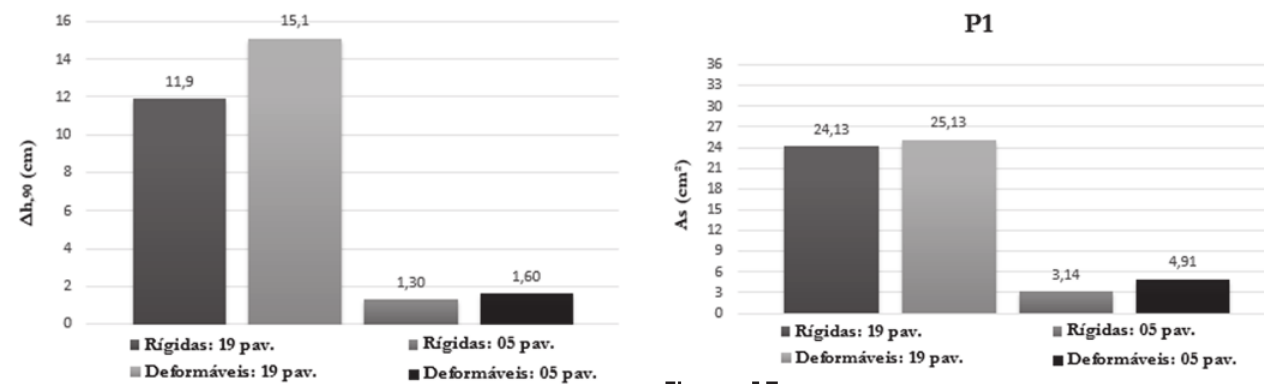
Figura 17 Modelo de Alva e El Debs [21]: armadura do pilar P1 da estrutura com 19 e 5 pavimentos, considerando ligações rígidas e ligações deformáveis